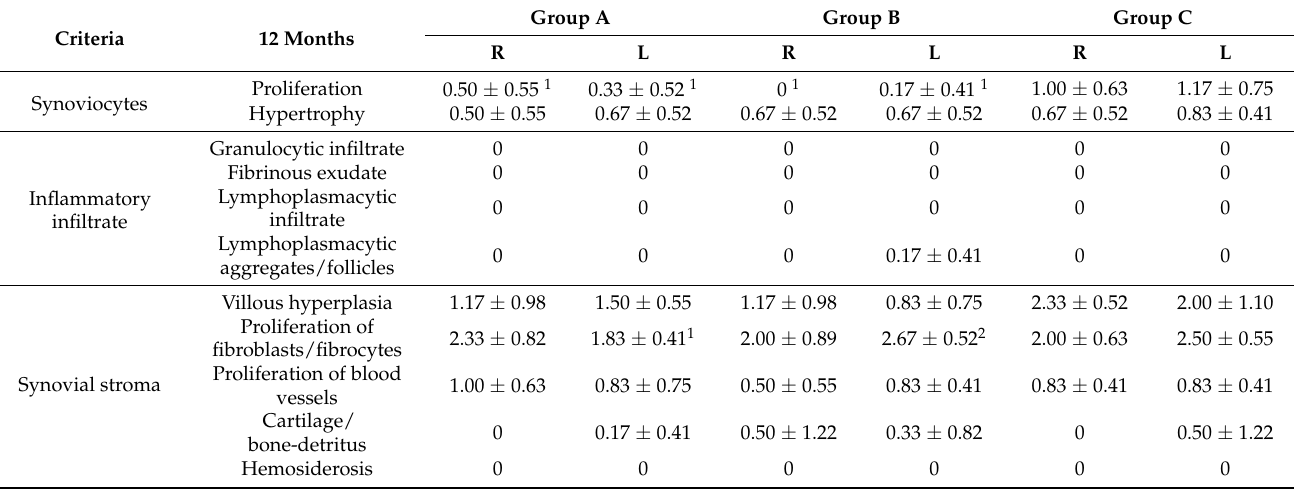
Table 3. Histopathological assessment of osteoarthritis synoviopathy for different experimental groups.